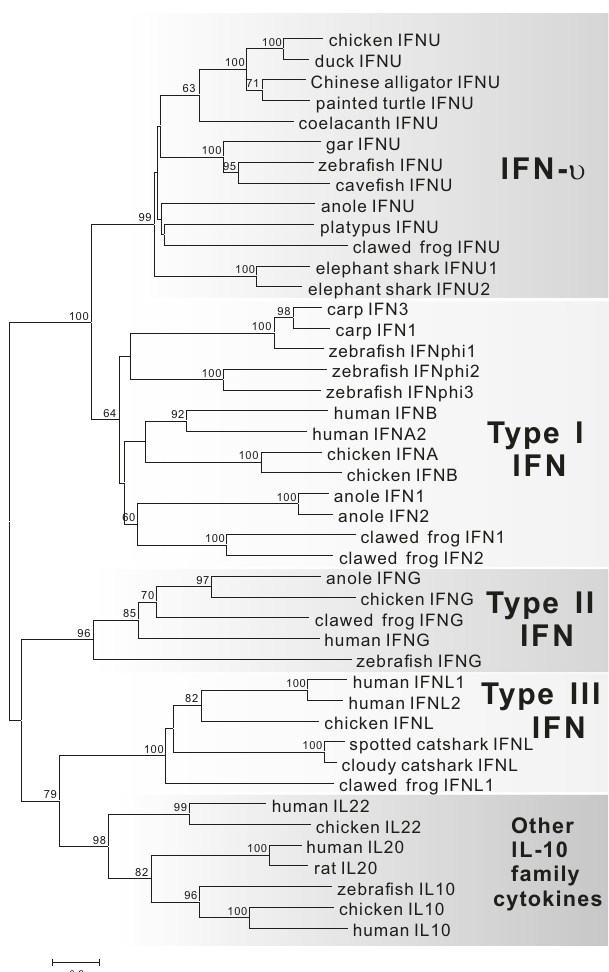
Fig. 5 Gene synteny of type I to IV IFNs. Gene synteny of IFNU ( a ), type I ( b ), II ( c ) and III IFN ( d ) loci in vertebrates. All genes are indicated with arrow symbols which point to the transcription direction. IFNU , type I, II and III IFNs are dyed using red, blue, yellow and green, respectively. The conserved and non-conserved neighbor genes are illustrated in gray and white, respectively. Evolutionary topology is supported by a recent study 35 . ♯ indicating no reports on type III IFN in elephant shark, but in catshark 8 , and ♯♯ chicken type III IFN locus which belongs to the conserved “ IFNLB loci ” in reptile and bird 34 .